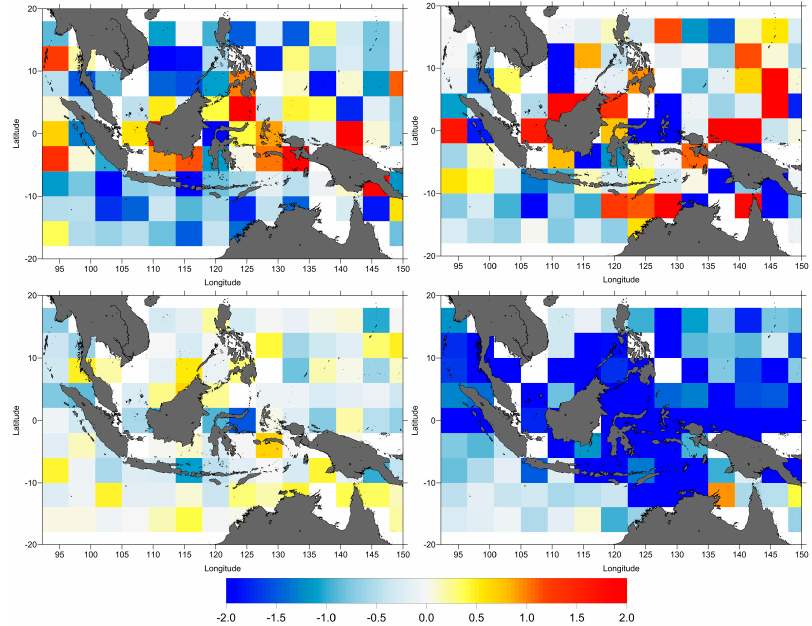
Figure 13. Top panels: SLA variance differences at crossovers (cm 2 ), between Sea State Bias Non-Parametric CLS and Sea State Bias Parametric BM4 for TOPEX (( left ) TOPEX-A cycles 1 to 235; ( right ) TOPEX-B cycles 236 to 264); Bottom panels: corresponding differences between Sea State Bias Non-Parametric Tran2012 and CLS SSB models for Jason-1 cycles 1 to 259 ( left ) and Jason-2 cycles 1 to 280 ( right ).